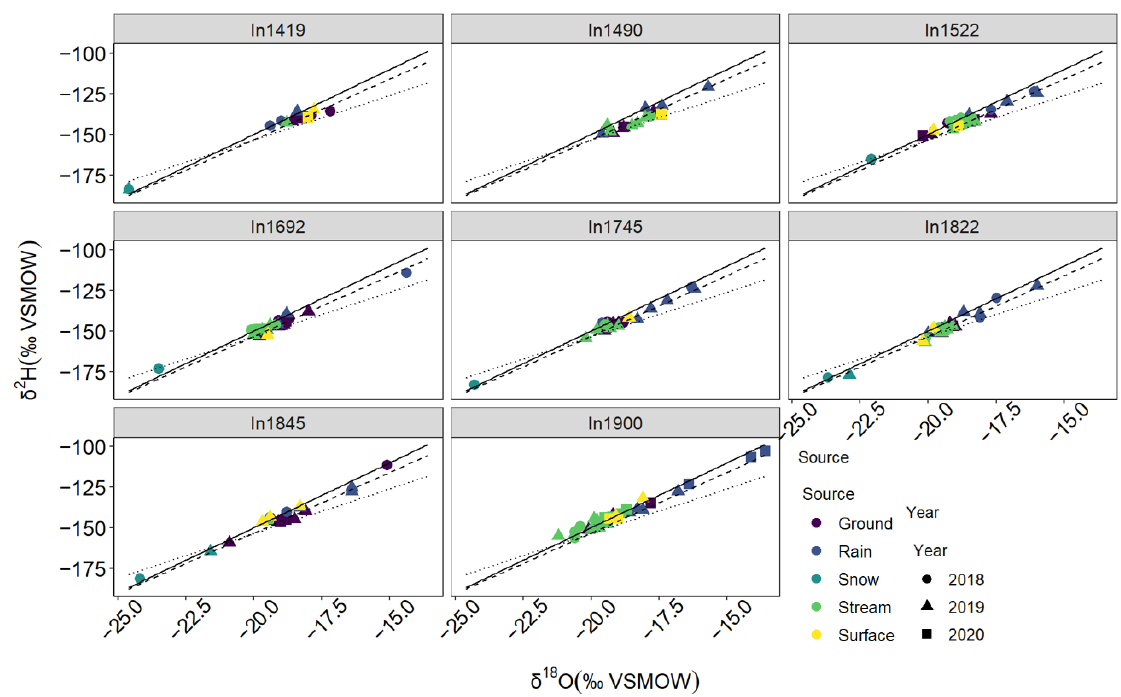
Figure 4. Dual Isotope plot grouping all source waters by color and year by shape for individual intensive sites ( n = 8). Global Meteoric Water Line (δ 2 H − 8 × δ 18 O + 10), Local Meteoric Water Line (δ 2 H − 7.488 × δ 18 O − 3.7), and Local Evaporation Lines (δ 2 H =5.498 × δ 18 O − 43.74) are shown as solid, dashed and dotted lines, respectively. The local evaporation lines are for the Kananaskis Valley, Alberta.